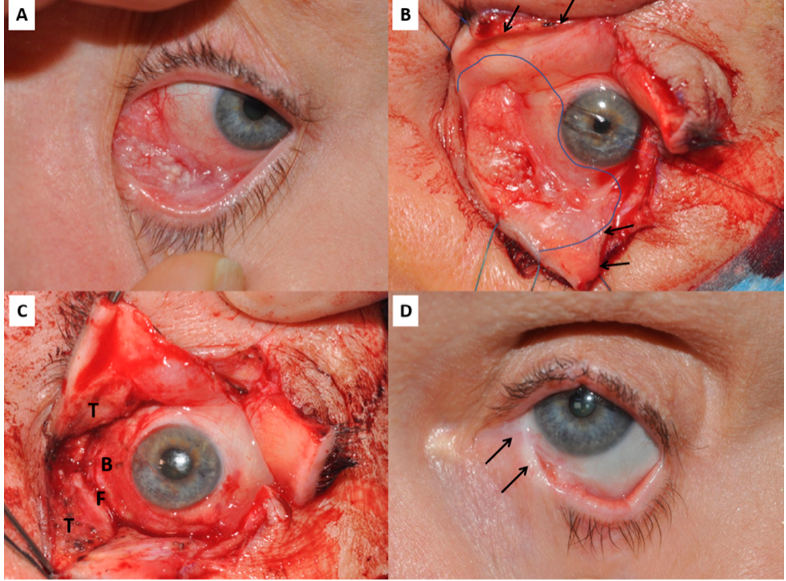
Figure 1. ( A ) Conjunctival squamous cell carcinoma affecting the infero-medial quadrant of the left eye. ( B ) Same patient during surgery. The upper and lower eyelids have undergone a full-thickness vertical lid-split procedure (arrows mark the cut edges) to improve visualisation and access to the tumour. The intended resection margin is shown by the curved line. ( C ) Following resection of the tumour there is an extensive conjunctival defect involving the tarsal plates and conjunctiva (T), the inferior fornix (F) and the bulbar conjunctiva (B). ( D ) Late post-operative image of the same patient showing symblepharon between the lower lid and globe (arrows), despite reconstruction with amniotic membrane, a free tarsal graft to the lower lid and temporary Gore-tex sheets as spacers.